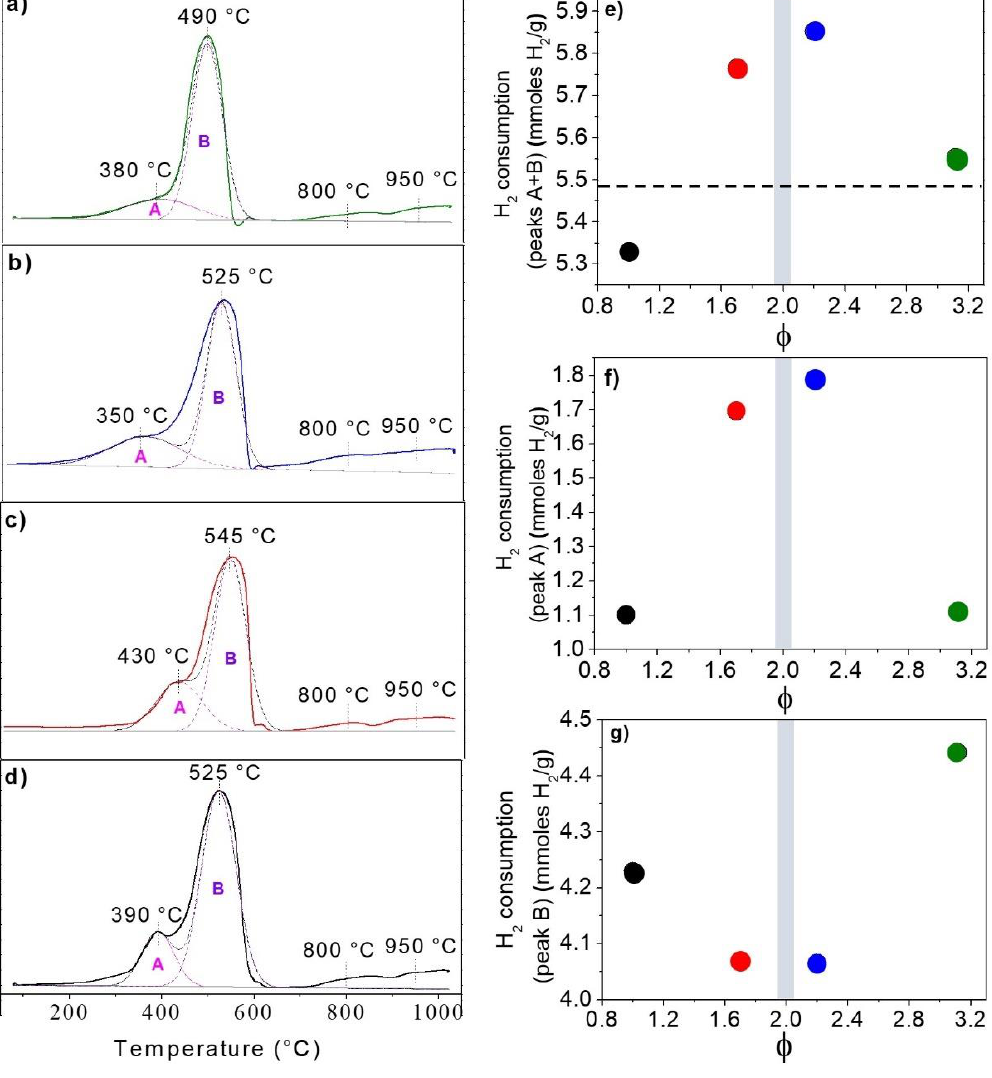
Figure 5. ( a – d ) H 2 -TPR profiles of the BSCF powders calcined at 950 °C for 5 h: ( a ) BSCF31 (green), ( b ) BSCF17 (red), ( c ) BSCF22 (blue) and ( d ) BSCF10 (black). ( e – g ) Volcano-type and other trends of H 2 -TPR parameters with Φ.